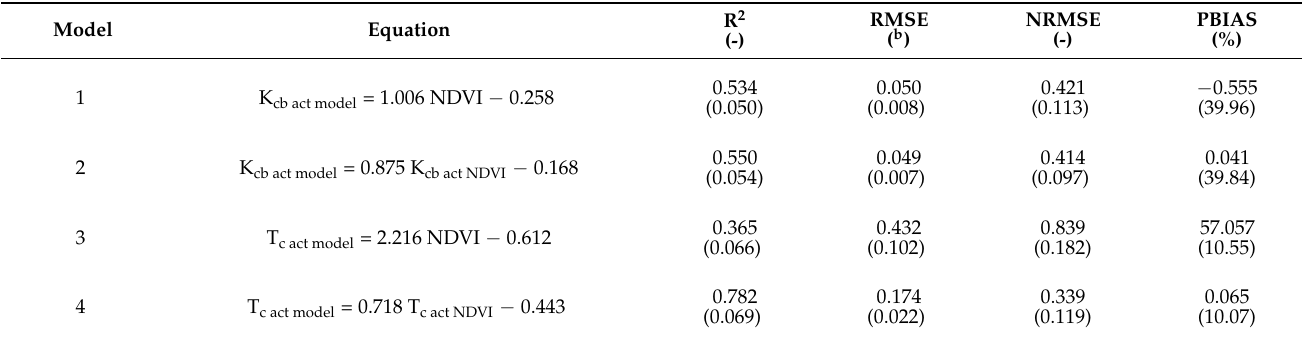
a K cbactmodel and K cbactNDVI , actual basal crop coefficient computed, respectively, from the MOHID-Land and satellite imagery; NDVI, normalized difference vegetation index; T aactmodel and T aactNDVI, actual transpiration computed, respectively, from the MOHID-Land and satellite imagery; R 2 , coefficient of determination; RMSE, root mean square error; NRMSE, normalized RMSE; PBIAS, percentage bias. b Units are the same as the variable